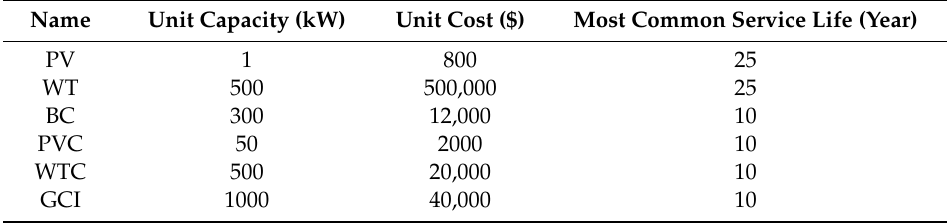
Table 1. The device parameters of the system.